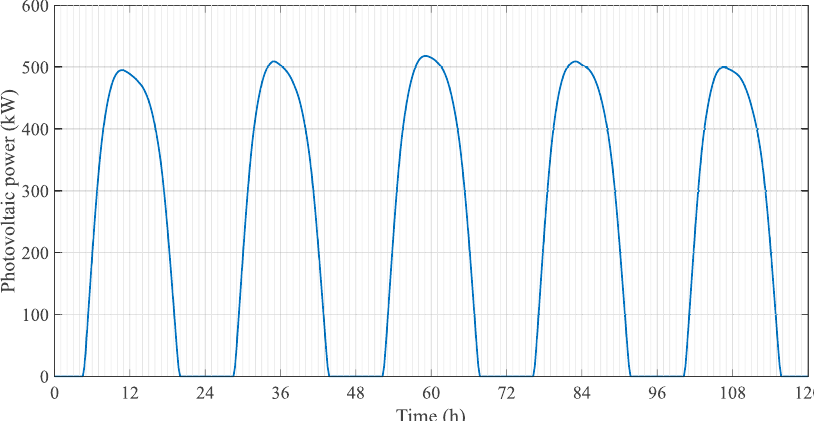
Figure 6. Forecast of the power provided by PV over the five days